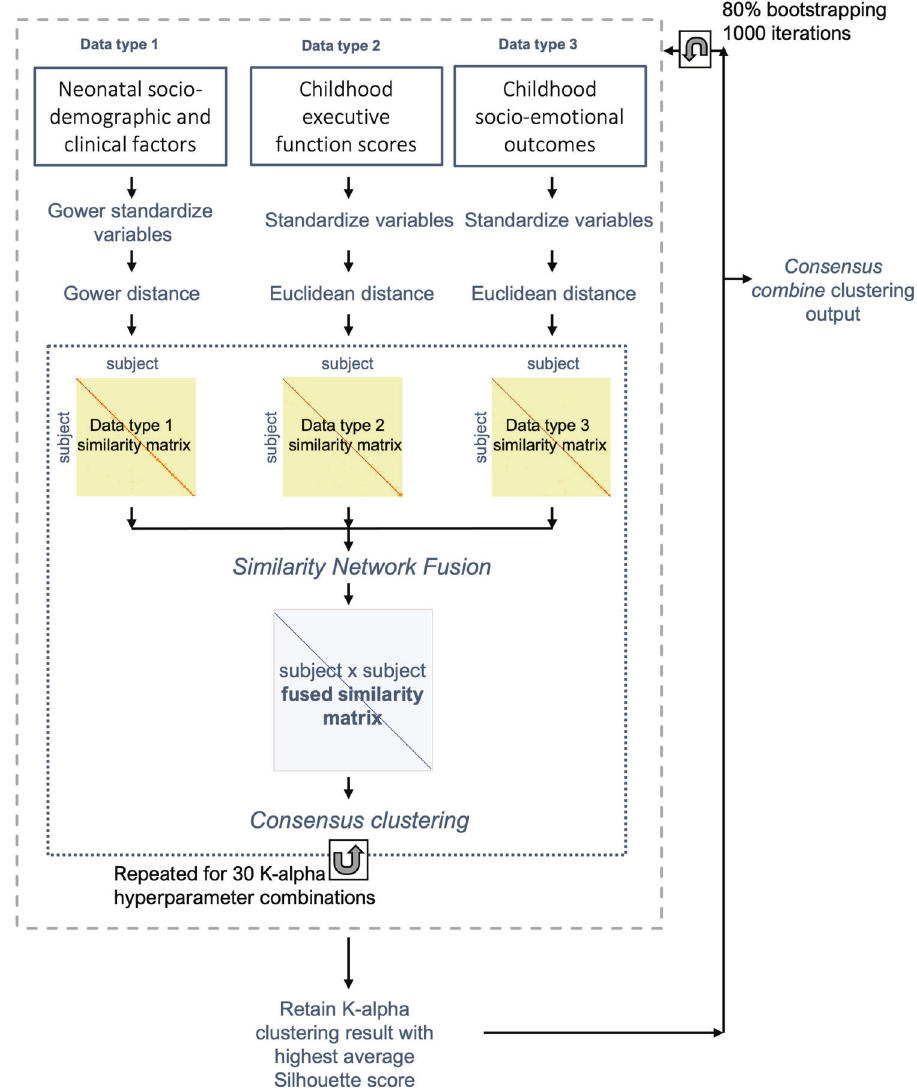
Fig. 1 Data integration and clustering pipeline. Figure summarizing the data pre-processing (variable normalization), data integration and clustering pipeline executed in order to obtain the fi nal consensus cluster